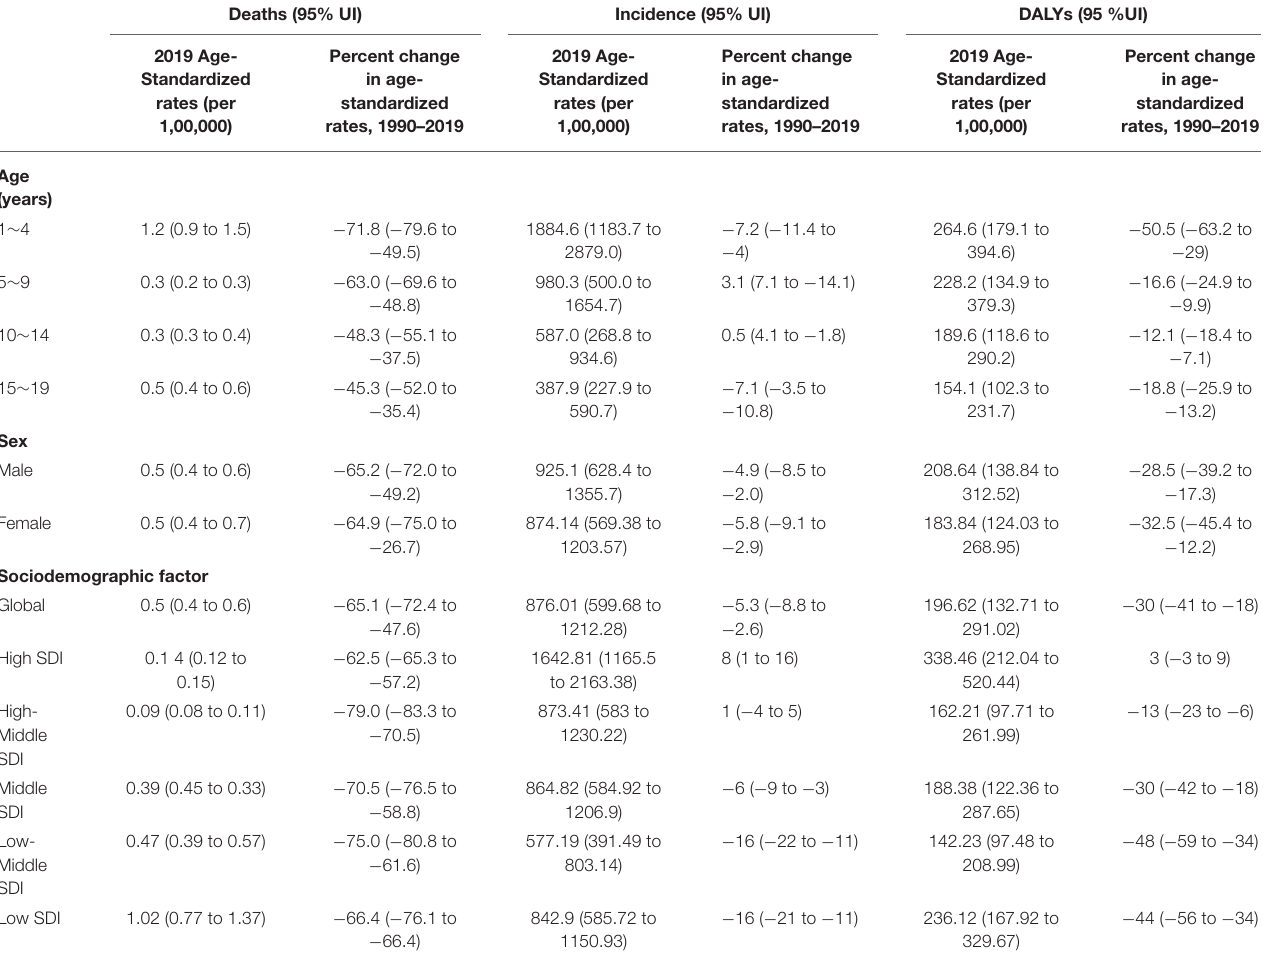
Frontiers in Pediatrics |